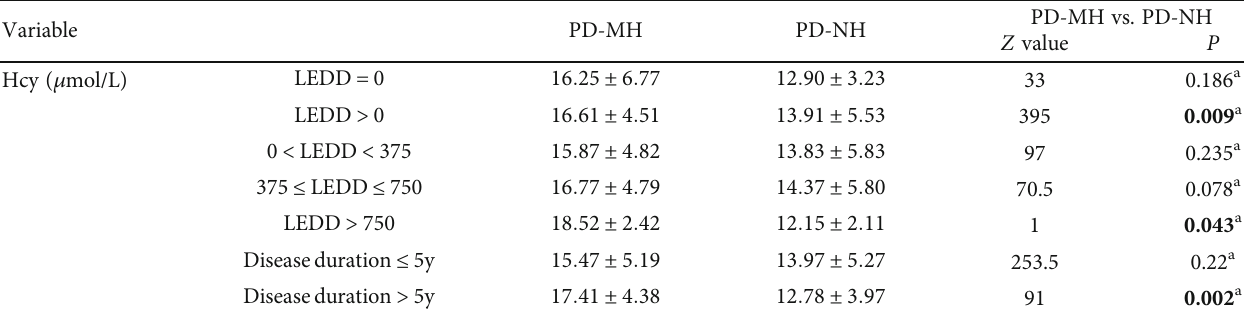
Table 4: Comparison of Hcy according to LEDD and disease duration.